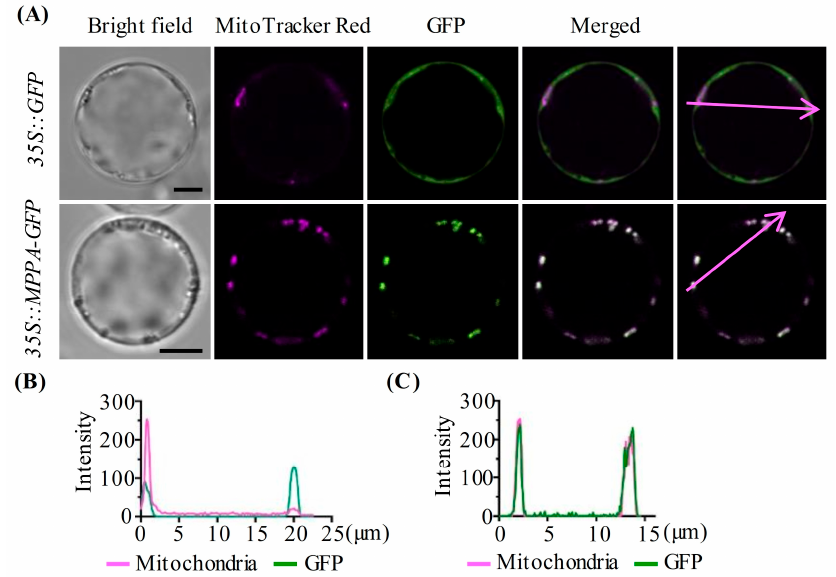
Figure 2. MPPA is localized to mitochondria. ( A ) Subcellular localization analysis of MPPA in rice protoplast. Magenta, MitoTracker Red, living cell fluorescent dye. GFP, green fluorescence protein. Bar = 5 μ m. ( B , C ) Quantification of co-localization of mitochondria and MPPA ( C ) and the GFP control ( B ).